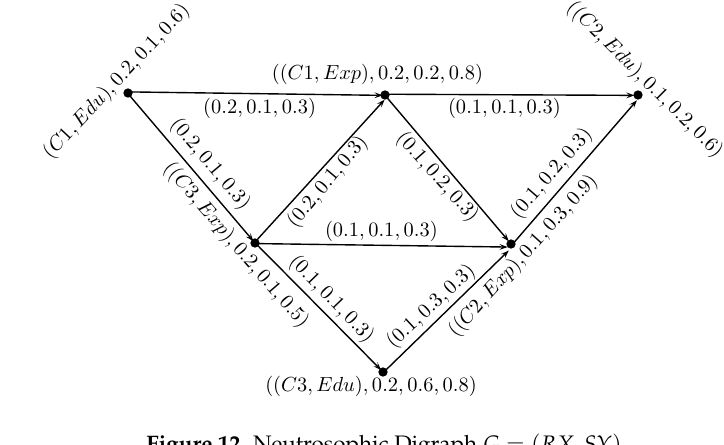
Figure 12. Neutrosophic Digraph G = ( RX , SY ) Figure 12: Neutrosophic Digraph G = ( RX,SY ) Figure 12: Neutrosophic Digraph G = ( RX,SY )